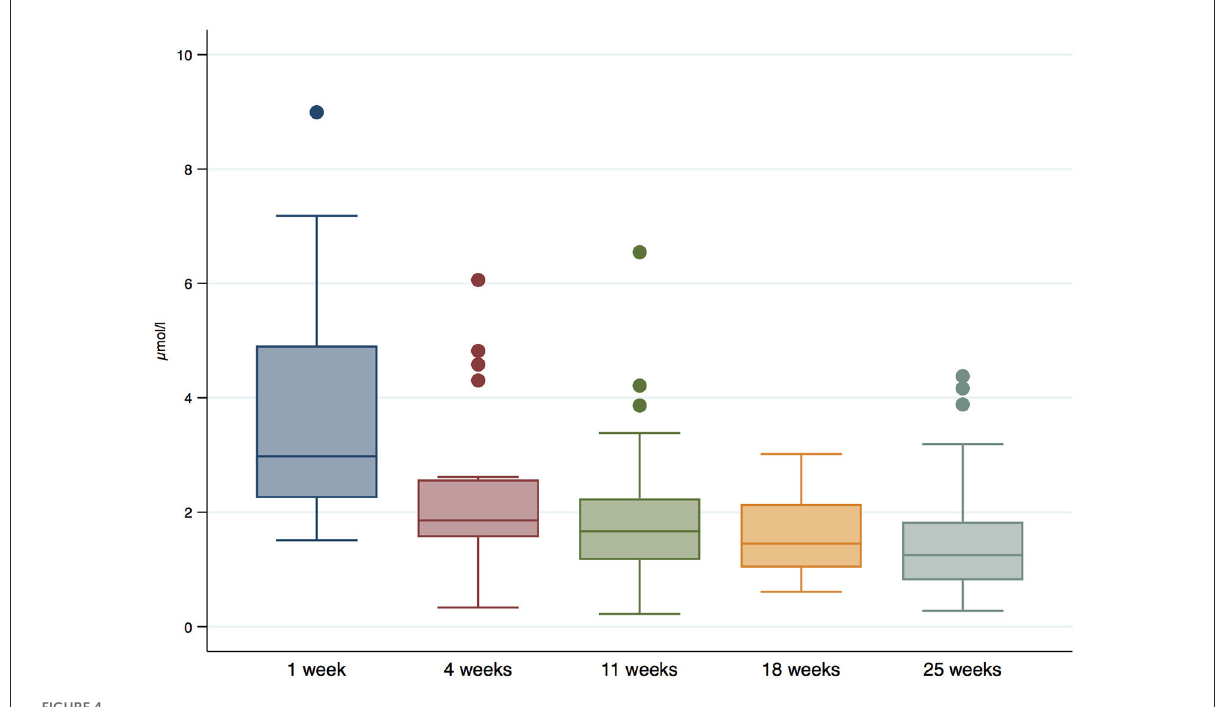
FIGURE4 Retinol levels ( µ mol/l) in HM during